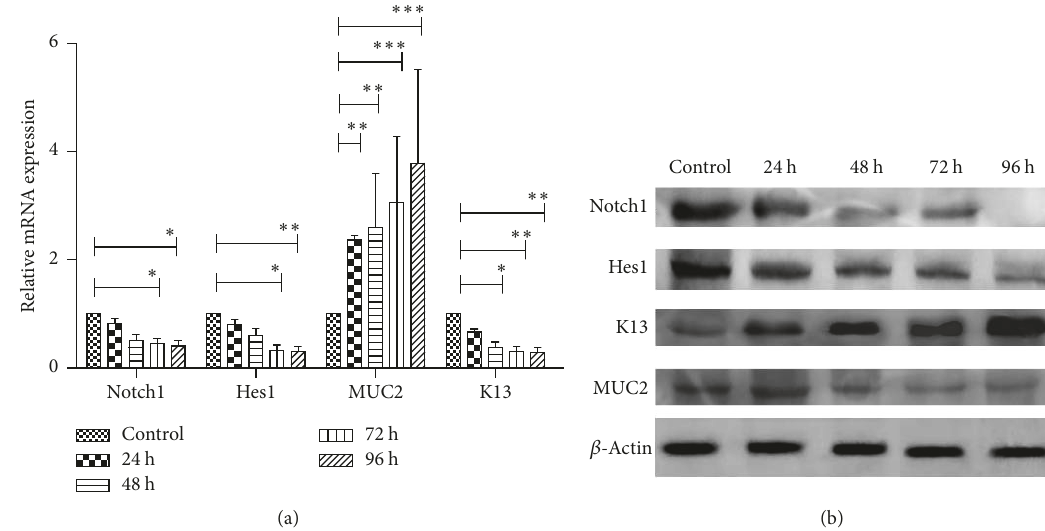
Figure 7: Effects of mixture of hydrochloric acid and deoxycholic acid on Notch1, Hes1, K13, and MUC2 expressions. Cells were treated with mixture of hydrochloric acid (pH = 5) and deoxycholic acid (500umol/L) for 24h, 48h, 72 h, and 96 h, respectively. (a) Notch1, Hes1, K13, and MUC2 mRNA expression levels in Het-1A cells exposing to mixture of hydrochloric acid and deoxycholic acid for different time periods. ∗ 𝑝 < 0.05 , statistically significant difference. ∗∗ 𝑝 < 0.01 , statistically significant difference. ∗∗∗ 𝑝 < 0.001 , statistically significant difference. (b) Representative western blot results of Notch1, Hes1, K13, and MUC2 protein expressions in Het-1A cells treated with mixture of hydrochloric acid (pH = 5) and deoxycholic acid (500 umol/L) for different time periods.